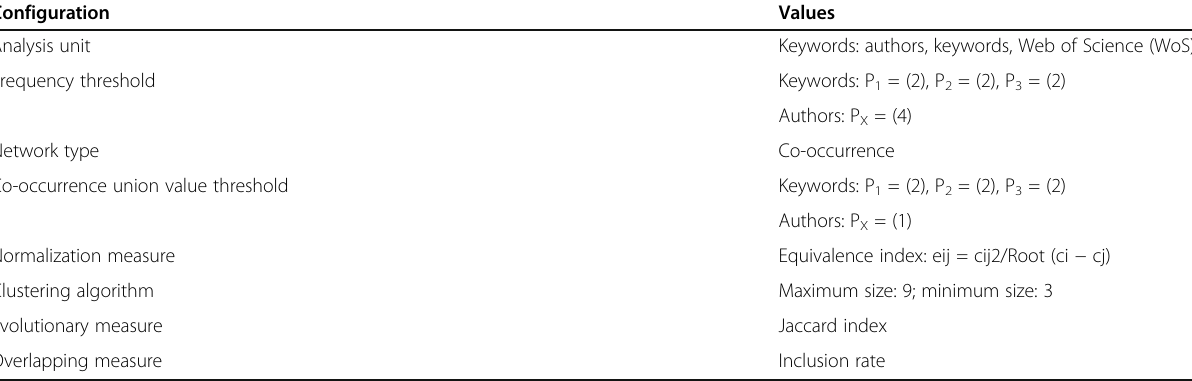
Table 1 Production indicators and inclusion criteria Configuration Analysis